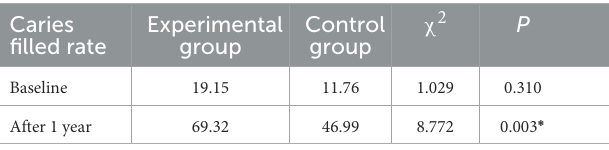
TABLE 6 The caries filled rate of first permanent molars in two groups before and after a year (%). Caries filled